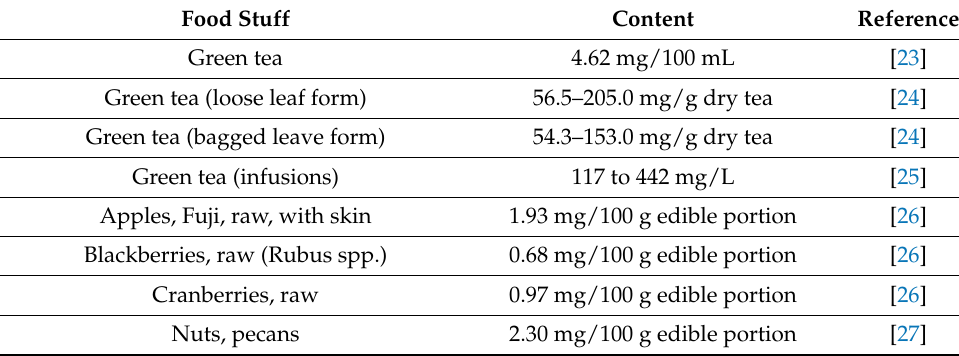
Table 1. Distribution of EGCG in various